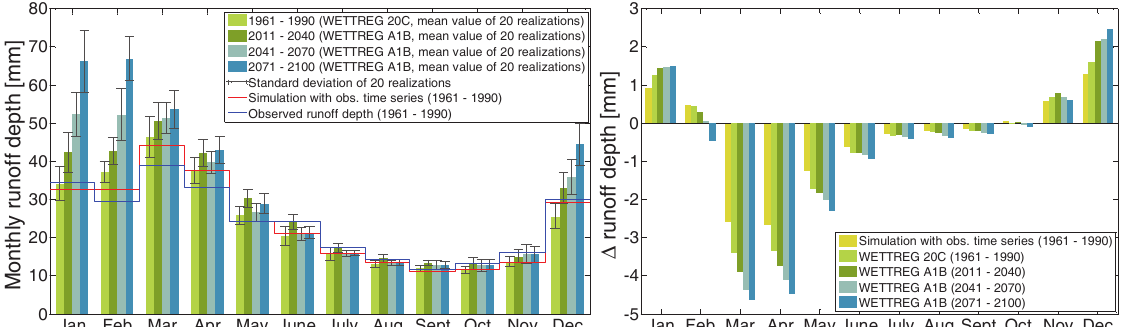
Fig. 5. Left panel: hydrologic simulation (monthly runoff depth) for different scenarios assuming a static, elevation-dependent vegetation course according to Fig. 4. Right panel: differences in simulated runoff depths between dynamic (GSI approach) and static parameterizations ( ∆ runoff depth = dynamic-static).